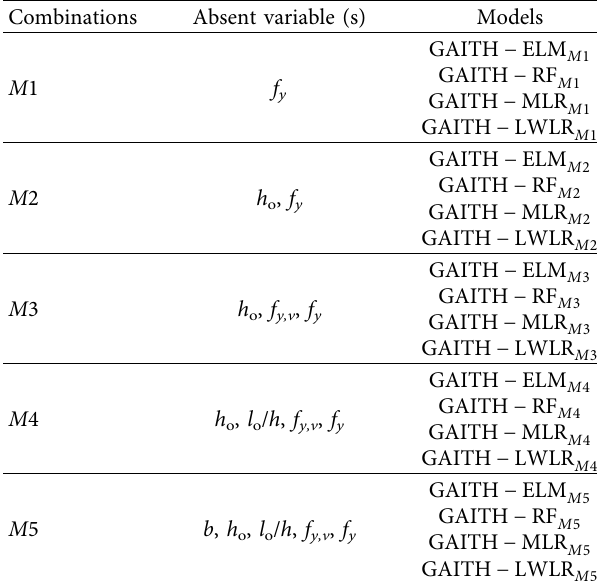
Table 3: The determination of the best input combination using the ITH-GA